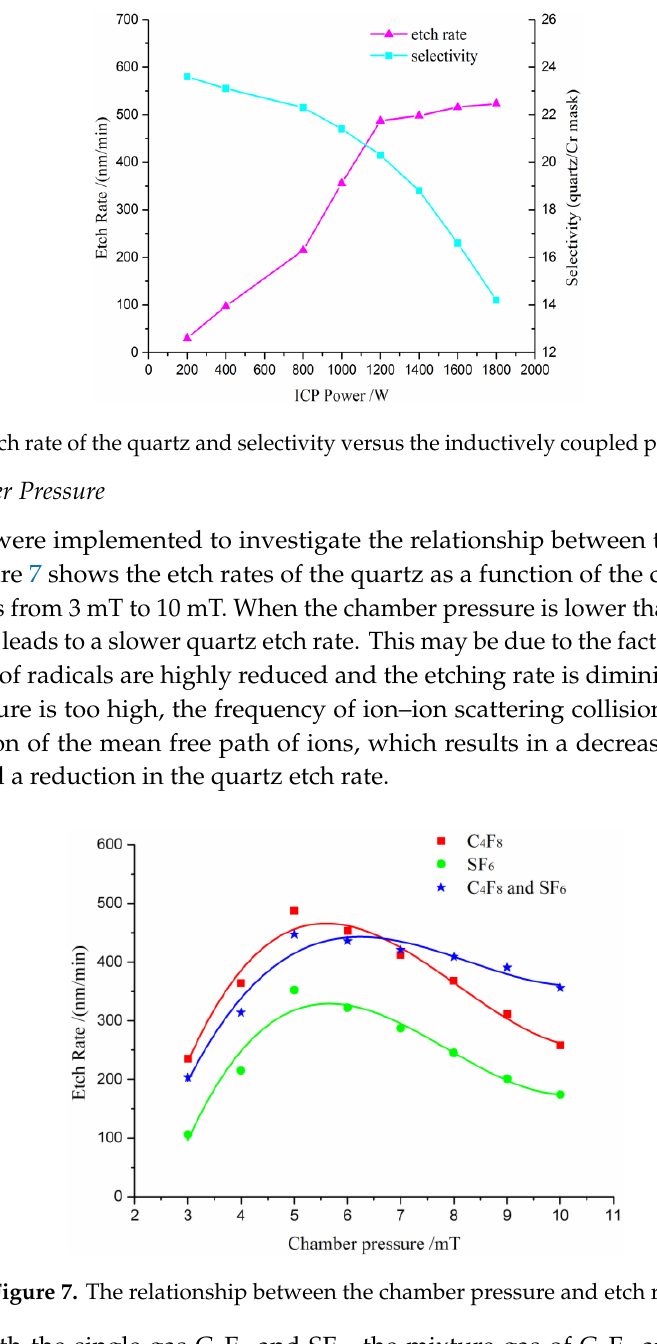
6 of 17 Figure 5. ( a ) Scanning Electron Microscope (SEM) picture of the rough etching bottom; ( b ) SEM picture of the enlarged partial bottom. 3.3. Effect of ICP Power The ICP power has an influence on the dissociation rate of the chemical gas. In other words, a higher dissociation rate leads to a higher etching rate. In Figure 6, the etch rate of the quartz and selectivity are plotted versus the ICP power, while keeping bias power = 200 W, gas pressure = 6 mT and gas total flow rate = 110 sccm. It is seen that the etch rate increases with ICP power, due to the increase in the reactive ion flux to the substrate surface. In other words, the increasing ICP power